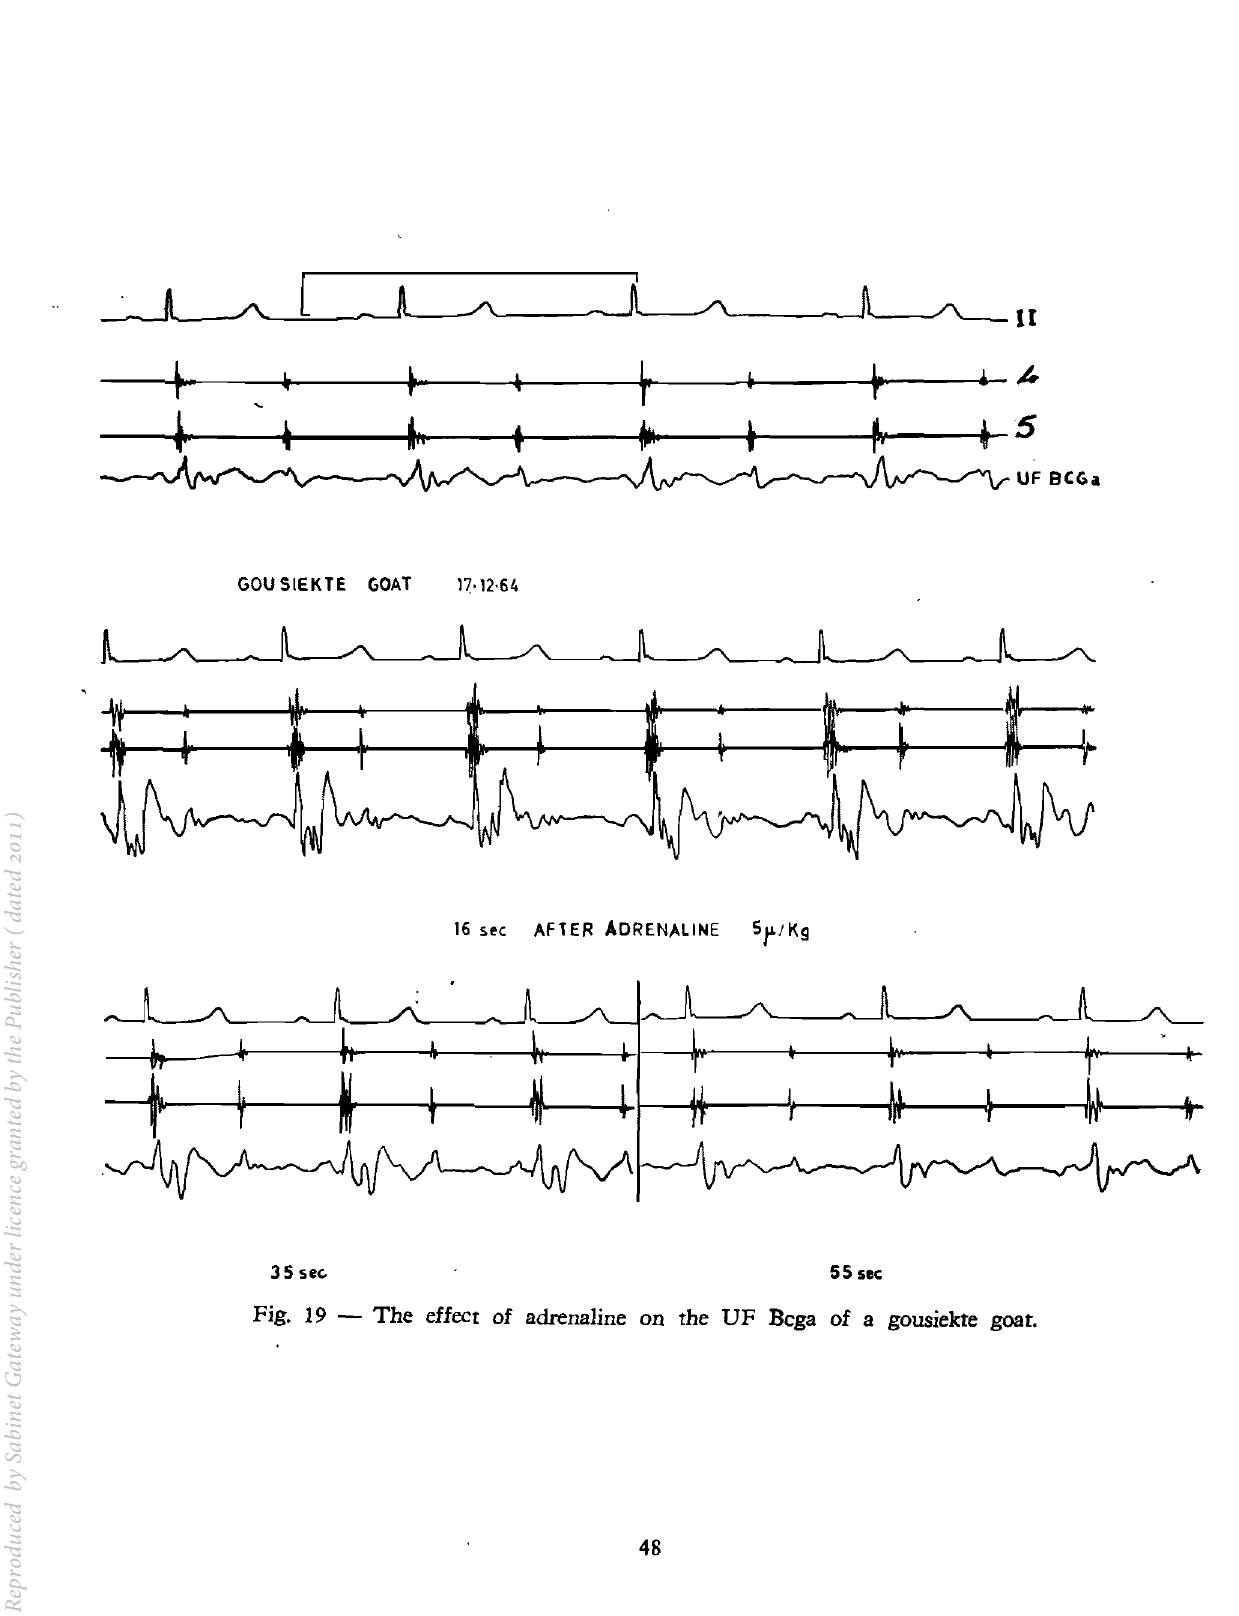
Fig. 19 - The effect of adrenaline on the UF Bcga of a gousiekte goat.